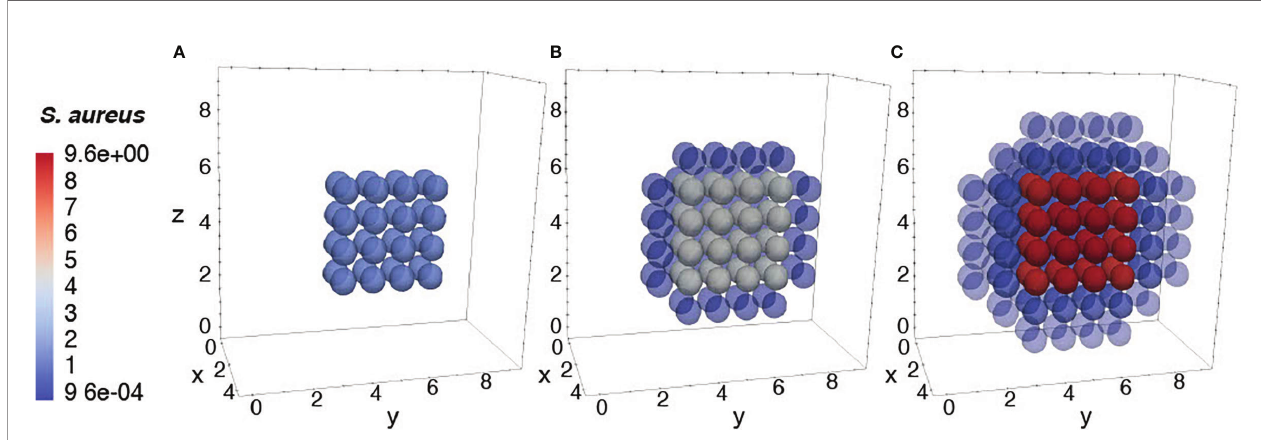
FIGURE 8 | Diffusion of the bacteria at different time periods. Initial condition of bacteria injected only at the center of the domain (A) , after 12h of simulation (B) , and after 24h of simulation (C) .